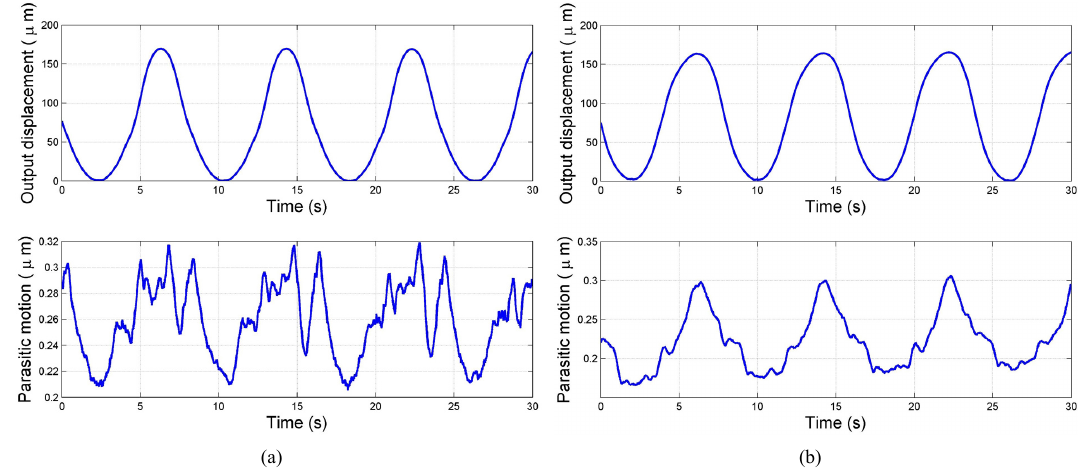
Figure 15. The output displacements and parasitic motions: (a) the output displacement of x -axis and parasitic motion of y -axis; (b) the output displacement of y -axis and parasitic motion of x -axis.